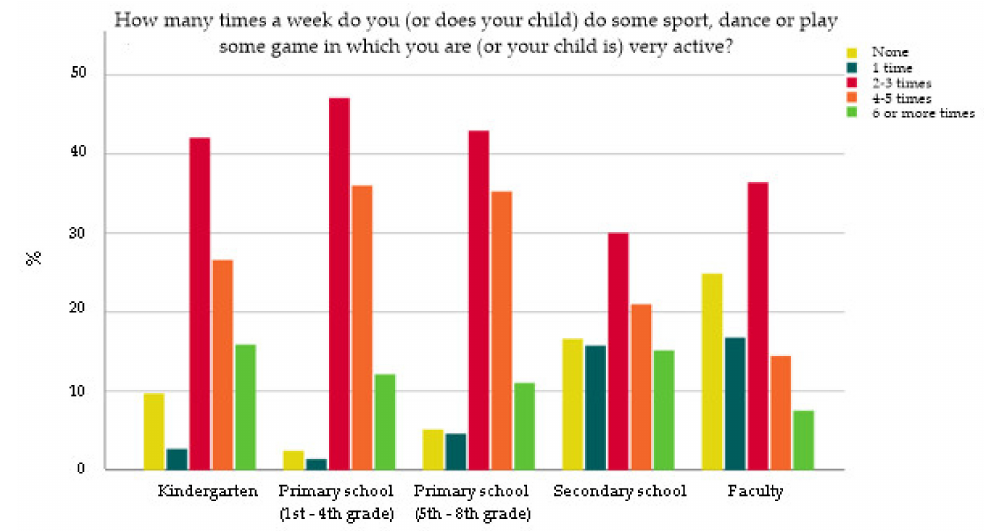
Figure 2. Distribution of answers to the question “How many times a week do you (or does your child) do some sport, dance or play some game in which you are (or your child is) very